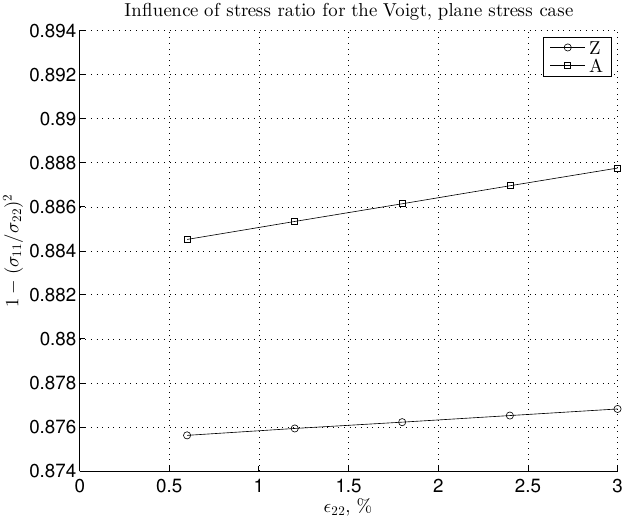
Figure 5. Plot of factors, including the stress ratio, that scales the expression for Young’s modulus in the plane stress state, which corresponds to the “V” BC case and a sample size of